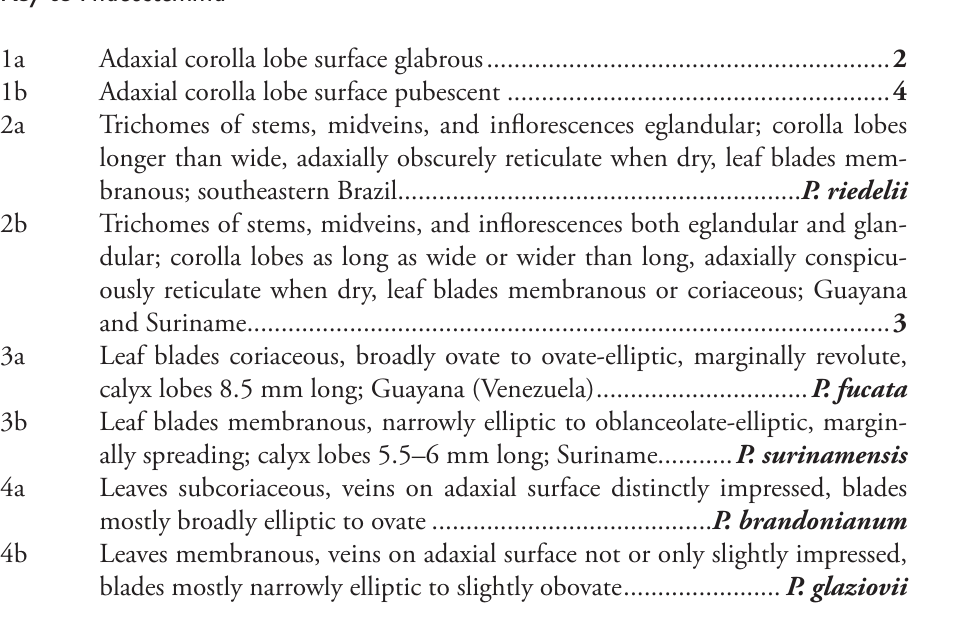
Matelea fucata Woodson, Fieldiana, Bot. ser. 28(3): 510. 1953. Type. VENEZUELA. Bolivar, Ptari-tepui, densely forested slopes overlying sandstone, alt. 1800 m, 8 Nov 1944, J. Steyermark 59963 (Holotype: MO!; Isotypes: F!, NY!,